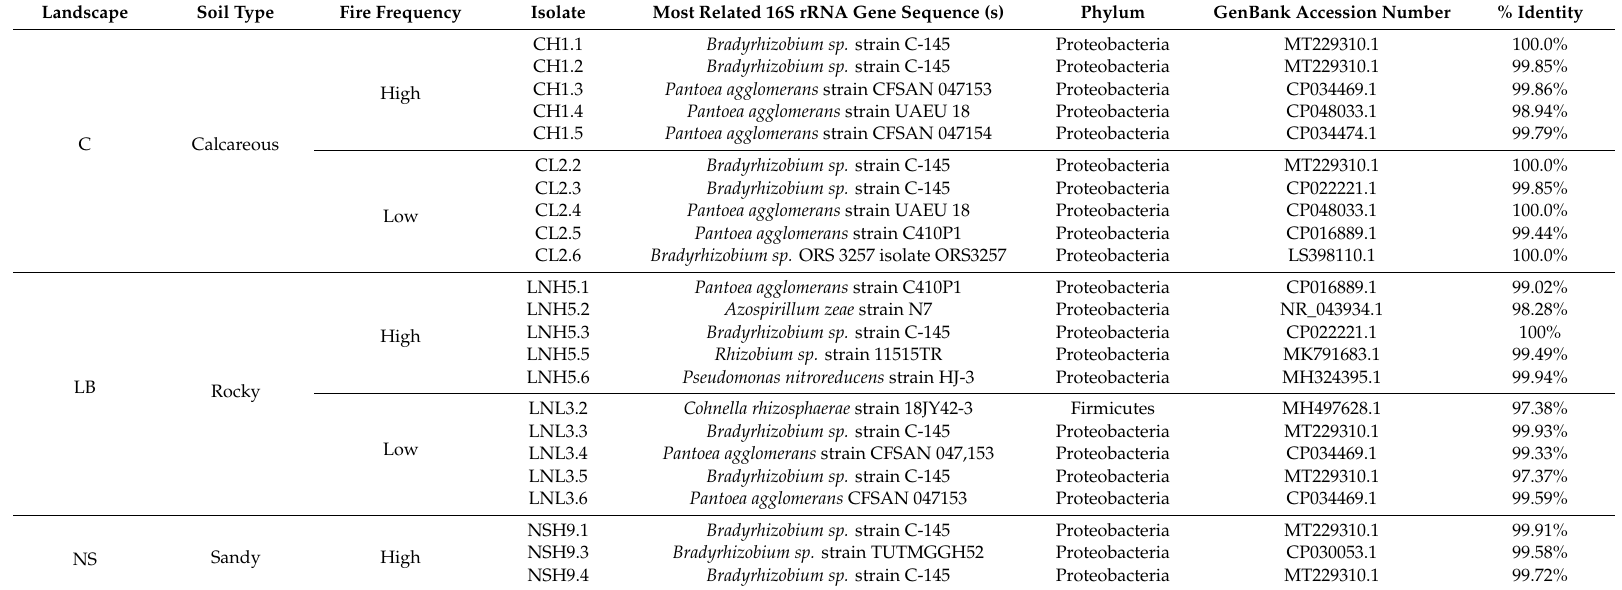
Table 5. Taxonomical identification of isolates from Vigna unguiculata root nodules inoculated with LPN soil samples, according to the most related source organism deposited in GenBank. Population codes follow Table